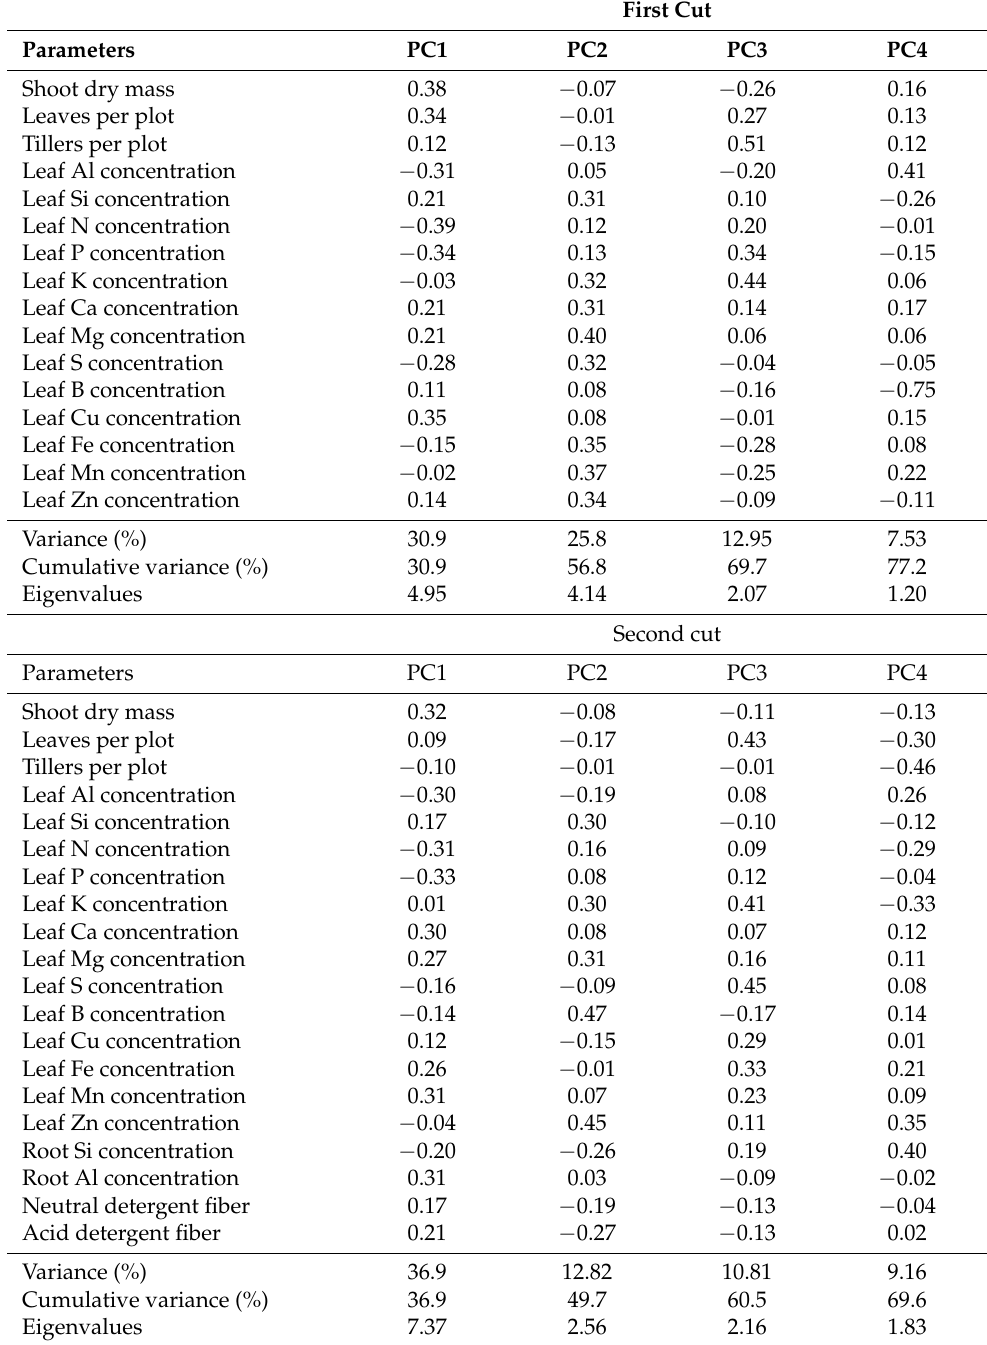
Table 2. Factor loadings of a principal component analysis for Xara é s